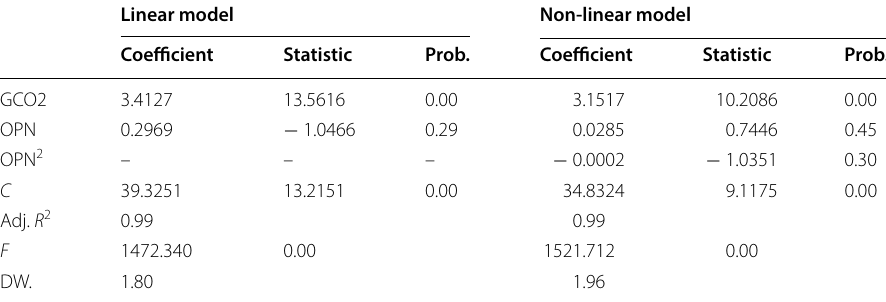
Table 6 Resulted coefficients and statistics of Model 3-L and Model